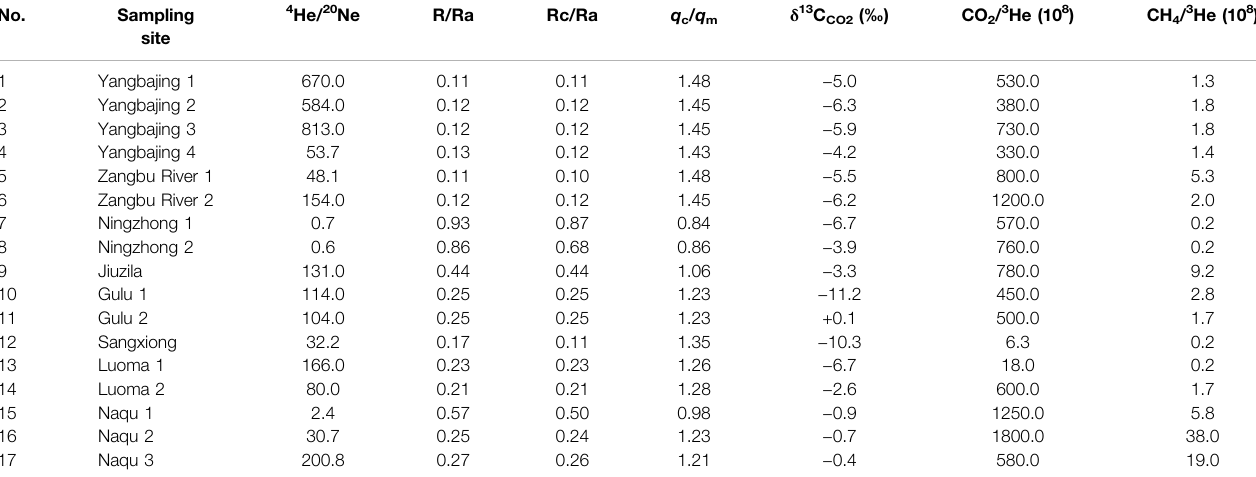
TABLE 2 | Isotopic compositions of He and CO 2 of hot spring gases in the northern Yadong-Gulu rift. No.